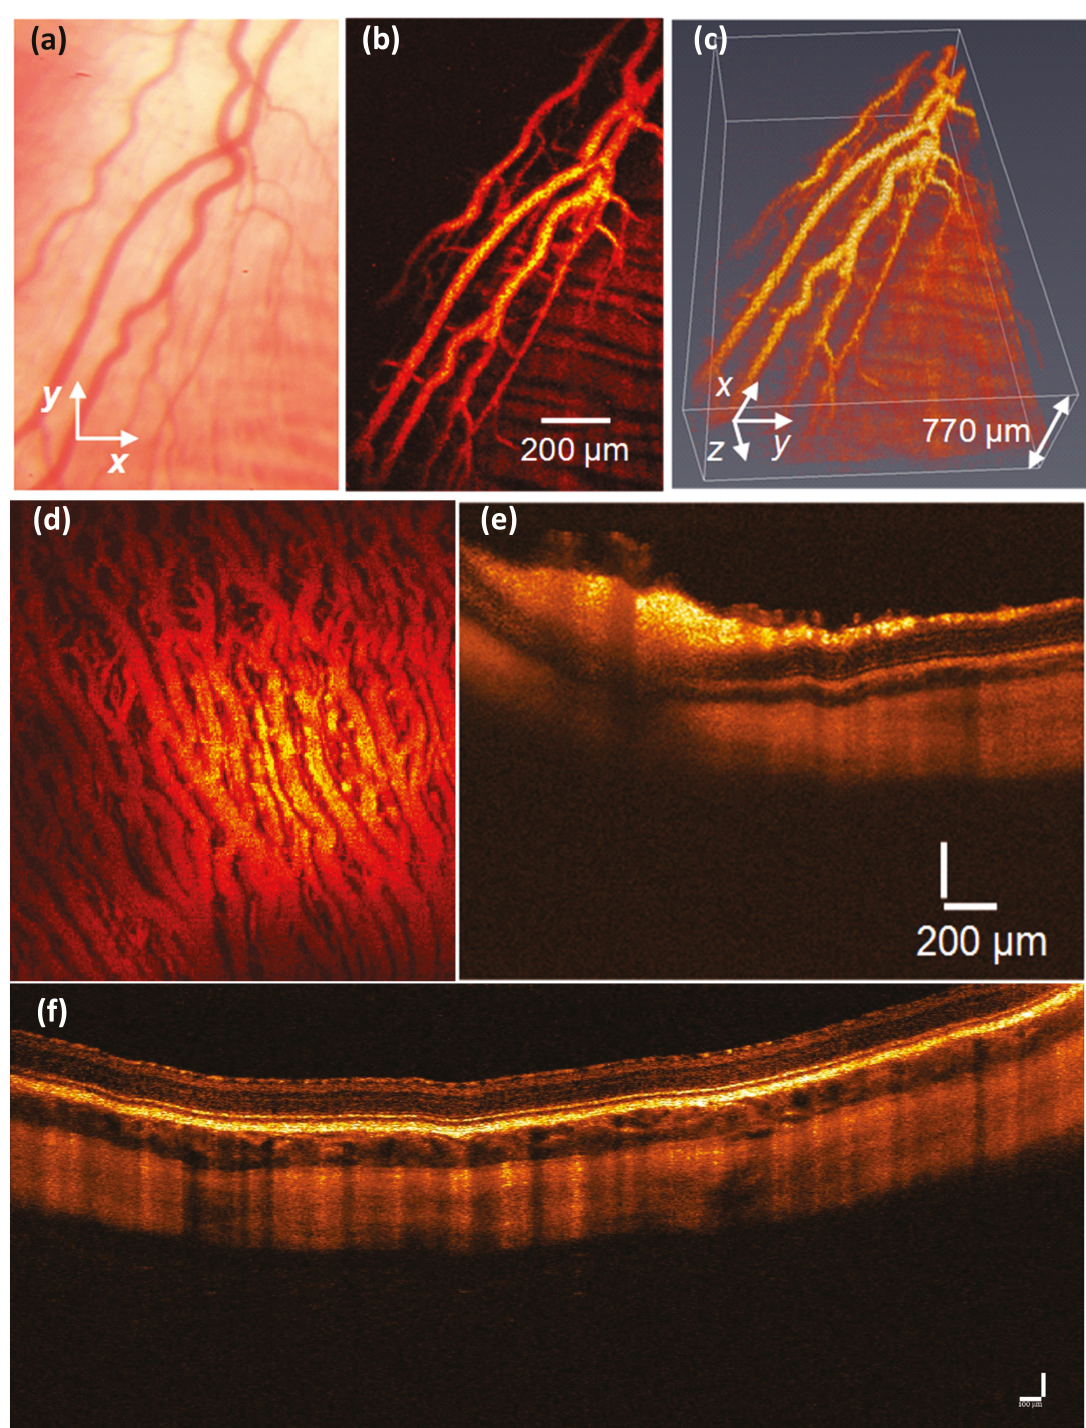
Figure 9. Photoacoustic microscopy of retinal and choroidal blood vessels in living rabbits: ( a ) color fundus photography, ( b ) corresponding PAM of retinal blood vessels, ( c ) 3D volumetric visualization of PA signal. ( d ) MIP PAM of choroidal vessels, ( e , f ) B-scan OCT images of retinal and choroidal blood vessels [14]. Adapted with permission from ref.